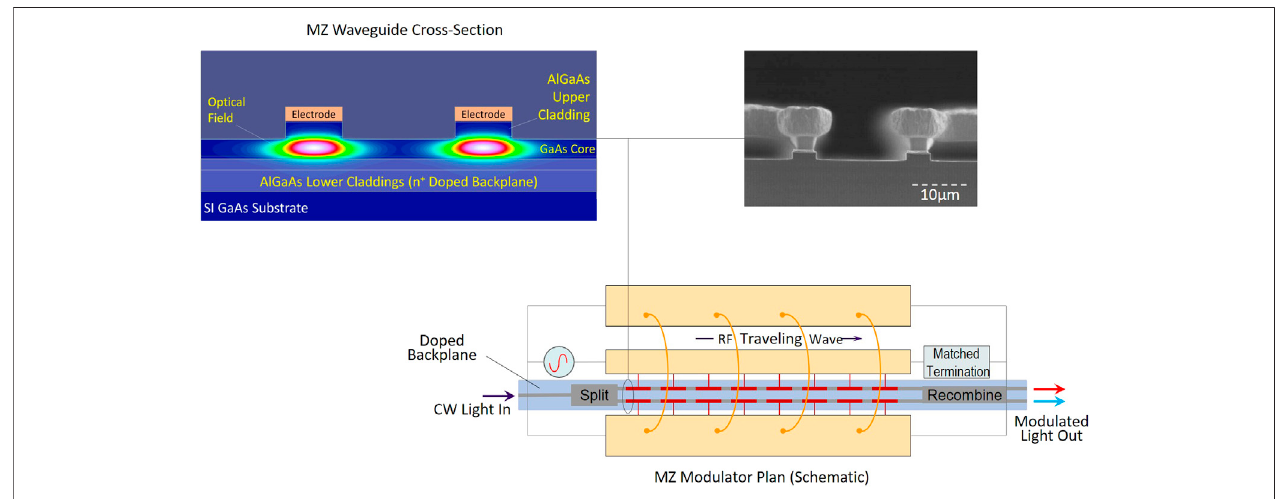
FIGURE 1 | Schematic (not to scale) of GaAs/AlGaAs loaded-line traveling wave modulator based on ground-strapped CPW transmission-line. Top left : waveguide cross-section with optical simulations (scalar fi eld) Top right: SEM micrograph showing rib waveguides with electrodes and plated air-bridges.